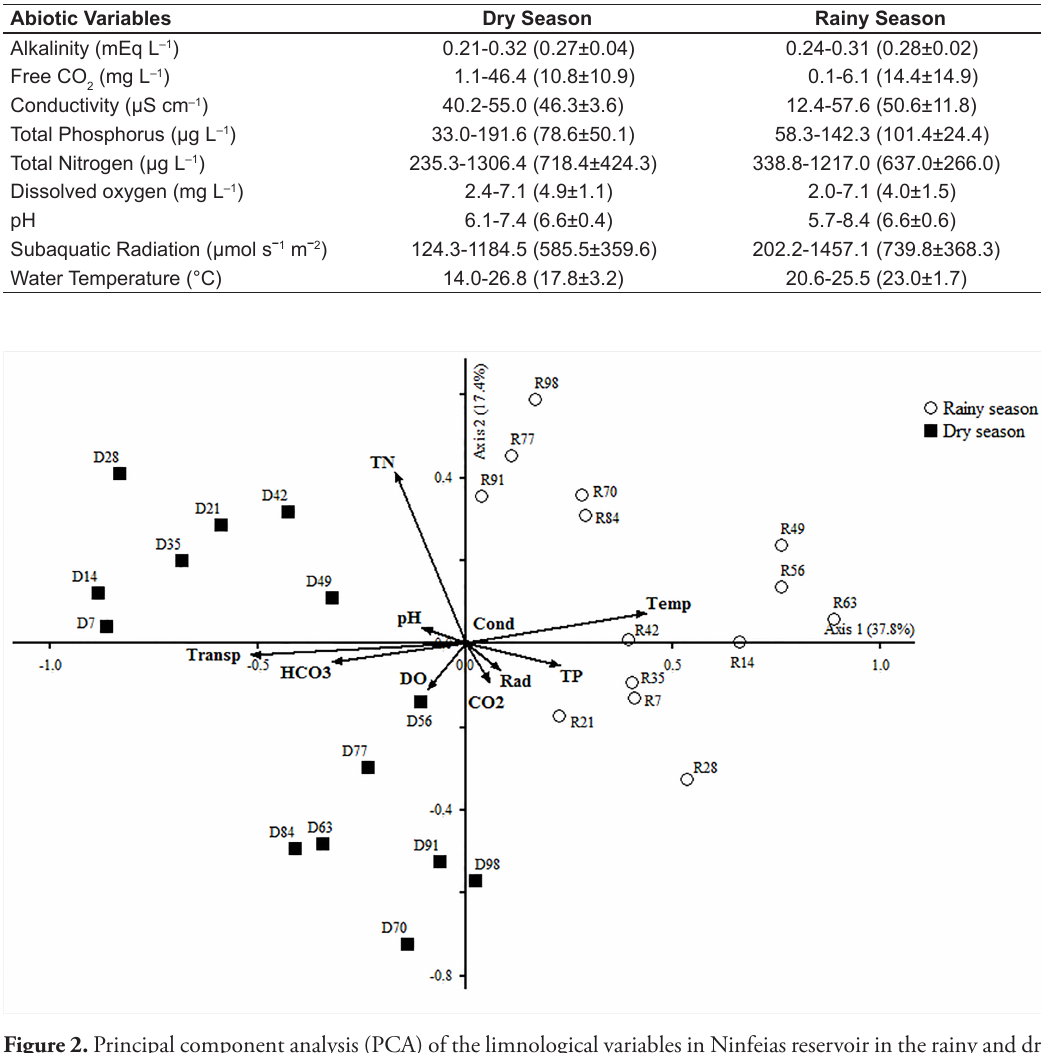
Table 1. Limnological variables ranges and, between parentheses, mean and standard deviation (n=14) in aquatic macrophyte stands during the dry and rainy seasons.